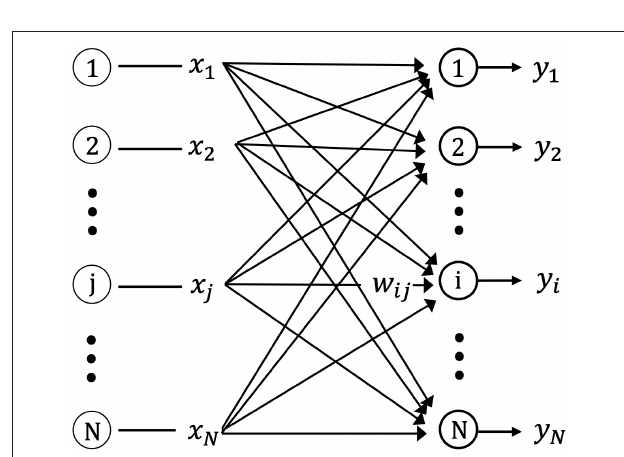
FIGURE 2 | Schematic diagram of the single layer feed-forward neural network. x j is the input from pre-synaptic neurons, y i is the output of post-synaptic neurons, and w ij is the connection weight matrix between pre-synaptic and post-synaptic